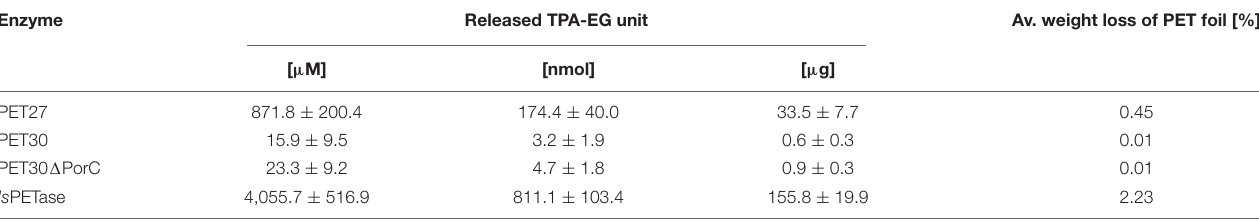
FIGURE 2 | Hydrolytic activities of PET27-PET30 on PCL, BHET, Impranil R (cid:13) DLN and PET foil. Activities on PCL, BHET and Impranil R (cid:13) DLN were visible by halo-formation on agar plates (A) . 10 µ l of purified enzyme (10-100 µ g) were applied to agar plates containing either 500 mg/l PCL, 5 mM BHET or 1% Impranil R (cid:13) DLN. Clearing zones were observed after 12 h at 30 ◦ C. Control indicates plates without enzymes but treated with 10 µ l buffer. UHPLC profiles of PET27 (B) and PET30 (C) after incubation on PET foil for 120 h. Two hundred microliter of recombinant and purified enzymes (1 mg/ml) were applied to amorphous foil and incubated over 120 h at 30 ◦ C. The Is PETase was included for reasons of benchmarking in (B) at 1 mg/assay (upper right corner). Graphs shown are representative graphs and were repeated at least three times. TABLE 2 | Amount of TPA released by different PET active